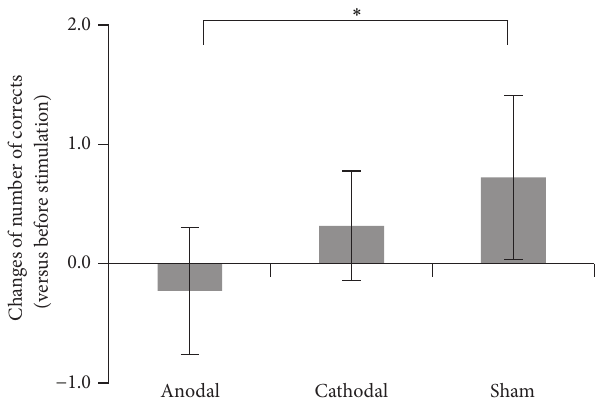
Figure 4: Mean tDCS effect on the number of correct sequences across participants in each (anodal, cathodal, or sham) session. The error bar indicates ± 1 SD. ∗ 𝑝 = 0.019